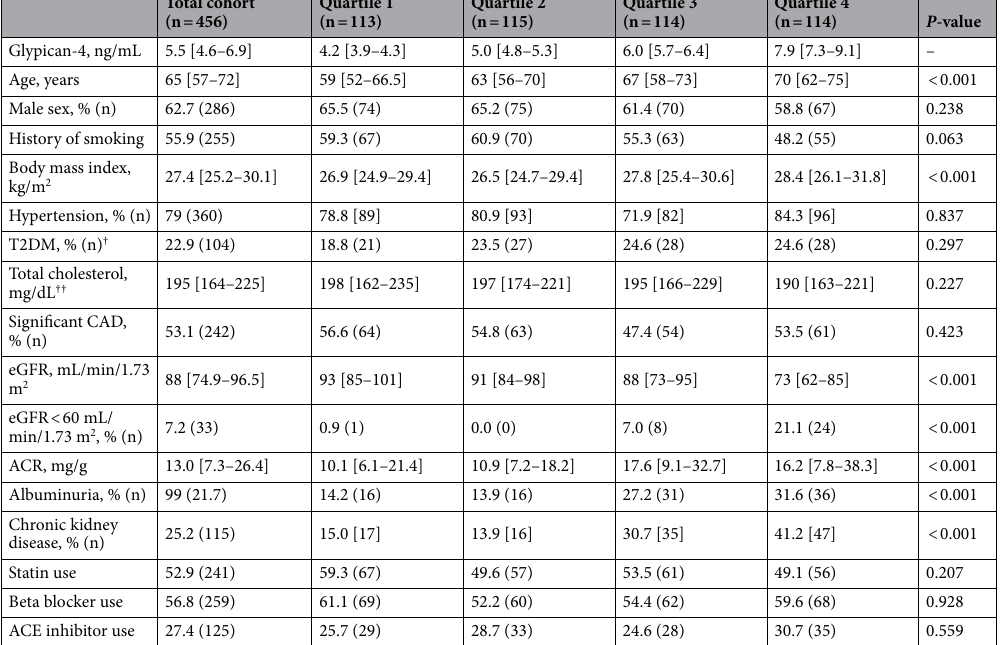
Table 1. Baseline characteristics of the total study cohort as well as stratified according to glypican-4 quartiles. † Missing samples: n = 1; †† missing samples: n = 2. Differences between baseline patients’ characteristics and glypican-4 quartiles were tested for statistical significance with the Chi-squared tests for trend for categorical and Jonckheere Terpstra tests for continuous variables, respectively. Continuous variables are given as median [interquartile range]. T2DM, type 2 diabetes mellitus; HOMA-IR, Homeostatic Model Assessment of Insulin Resistance; CAD, coronary artery disease; eGFR, estimated glomerular filtration rate; ACR, albumin-to- creatinine ratio; ACE, angiotensin converting